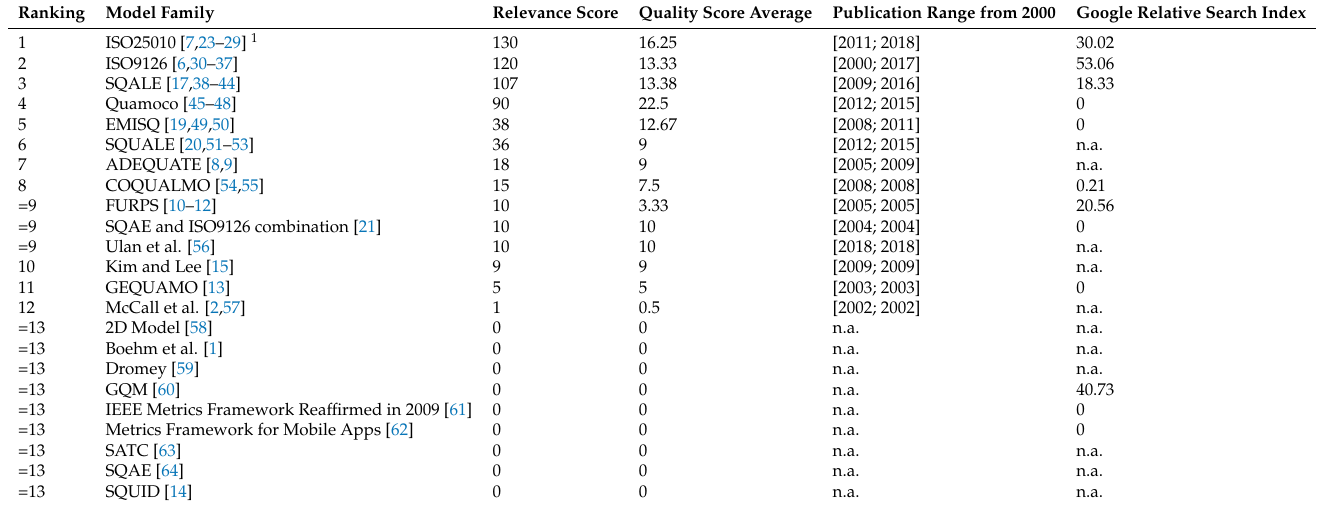
Table 1. Identified quality model families ranked by relevance scores [5]. Ranking Model